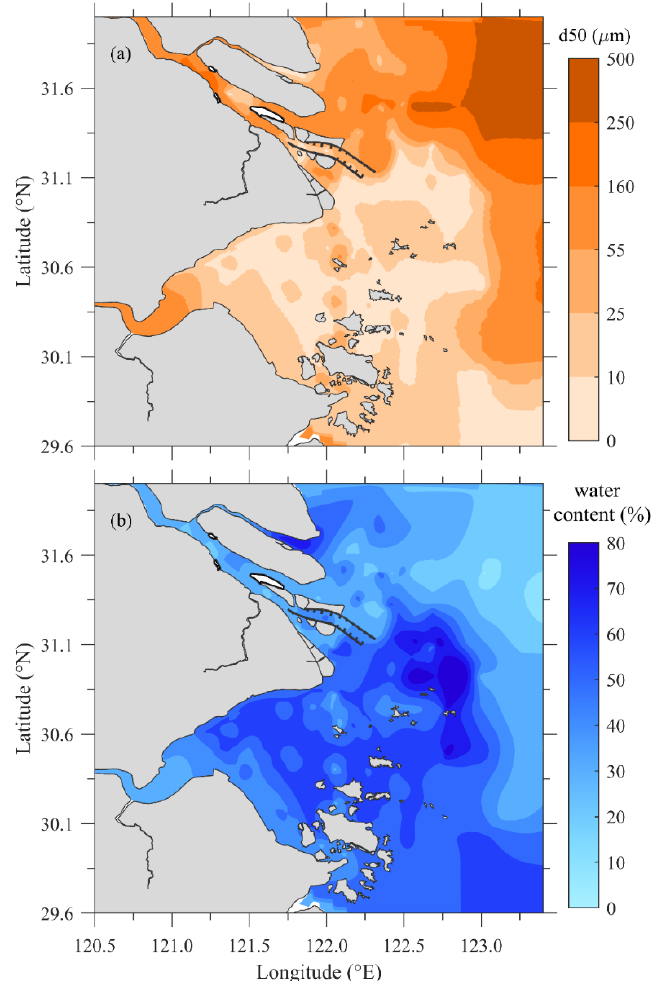
Figure 3. Distribution of median sediment diameter ( a ) and water content ( b ) of seabed sediment in Hangzhou Bay and the Changjiang Estuary.